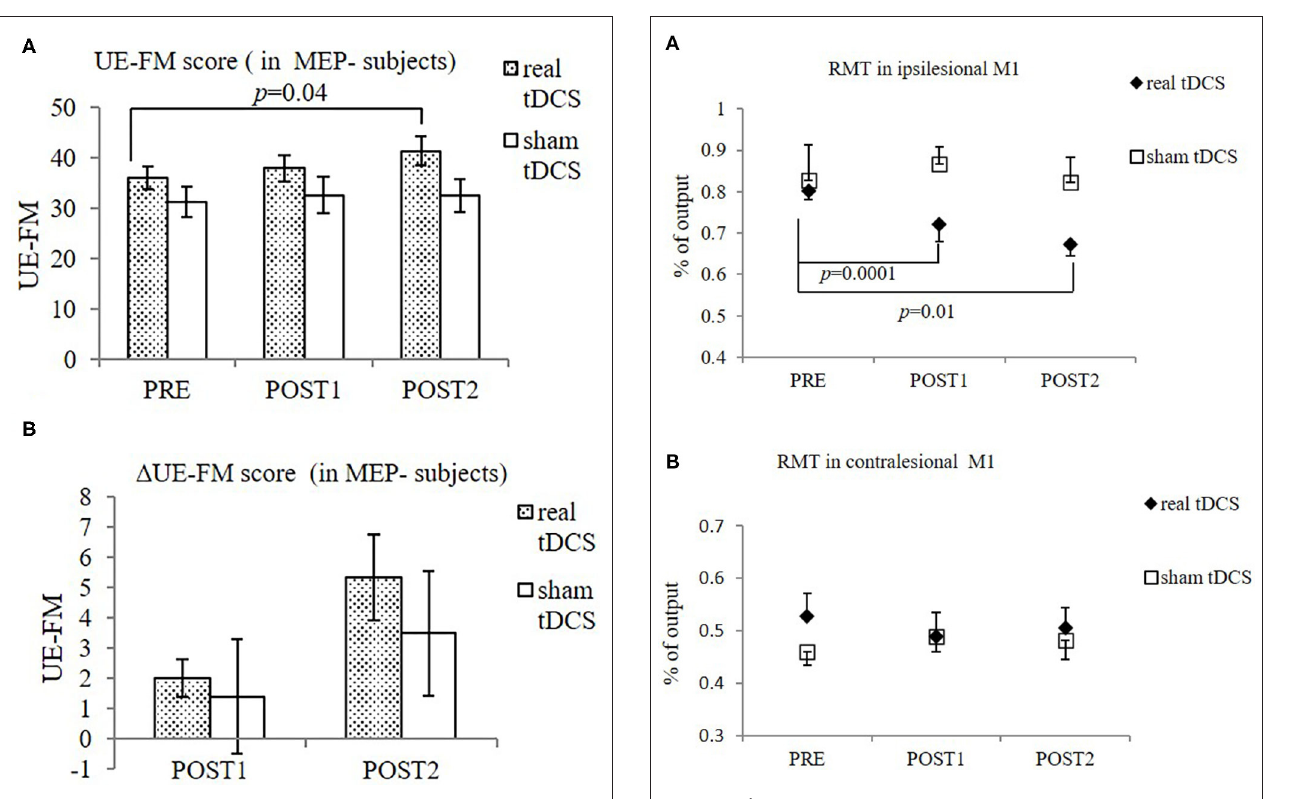
FIGURE 3 | UE-FM (A) and 1 UE-FM (B) in both groups in MEP- participants. (A) Significant improvement in UE-FM in the real-tDCS group ( n = 6), but not the sham-tDCS group ( n = 5). (B) No significant difference in 1 UE-FM was shown between groups, or over time. Data shows mean ± SEM. with greater changes in contralesional SICI 2ms ( 1 SICI 2ms ) ( r = −